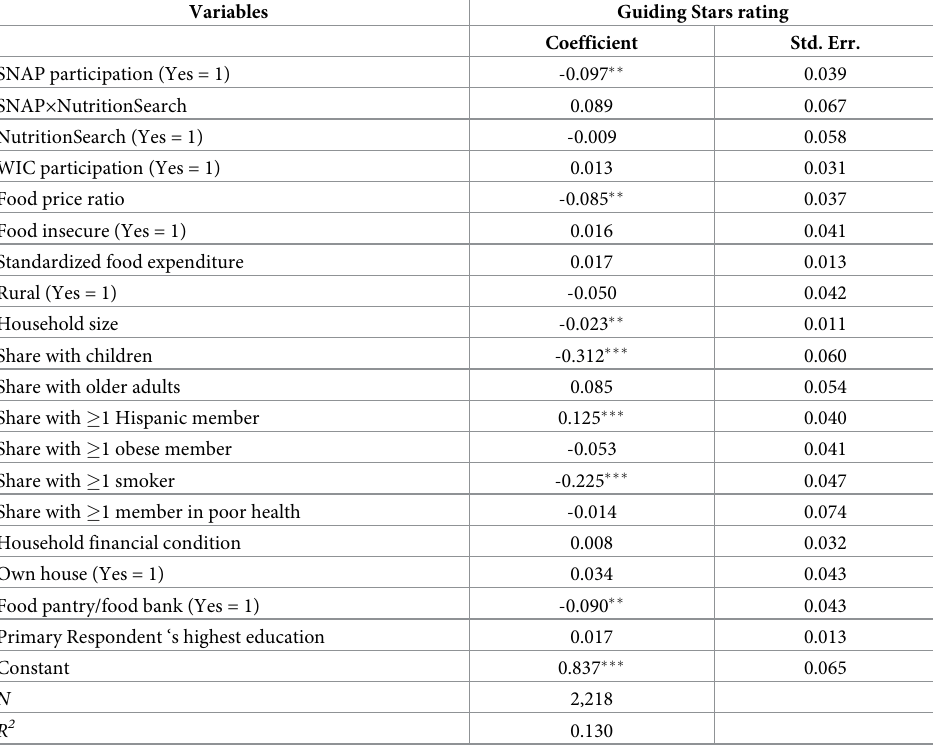
a Multivariate regression is applied to examine the association of SNAP with the Guiding Stars rating of FAH purchases. b The estimates use sample weights and control for survey design. Boldface indicates statistical significance ( ��� p < 0.01, �� p < 0.05, � p <